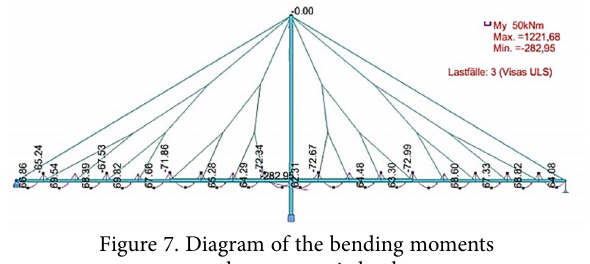
Figure 7. Diagram of the bending moments under symmetric load